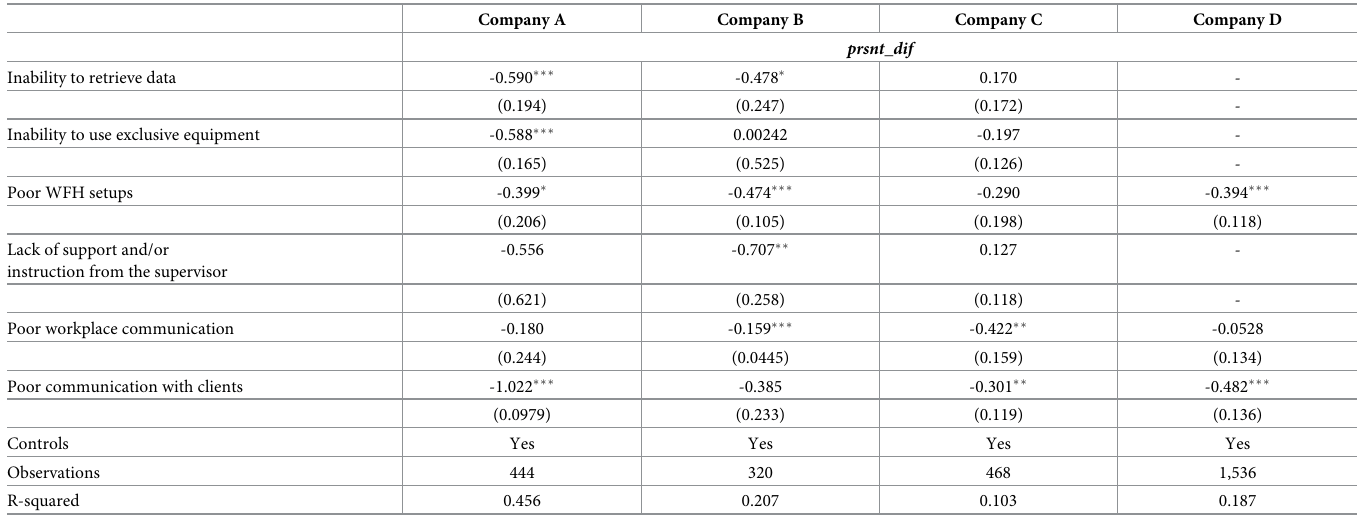
Table 6. Subsample analysis (sales).